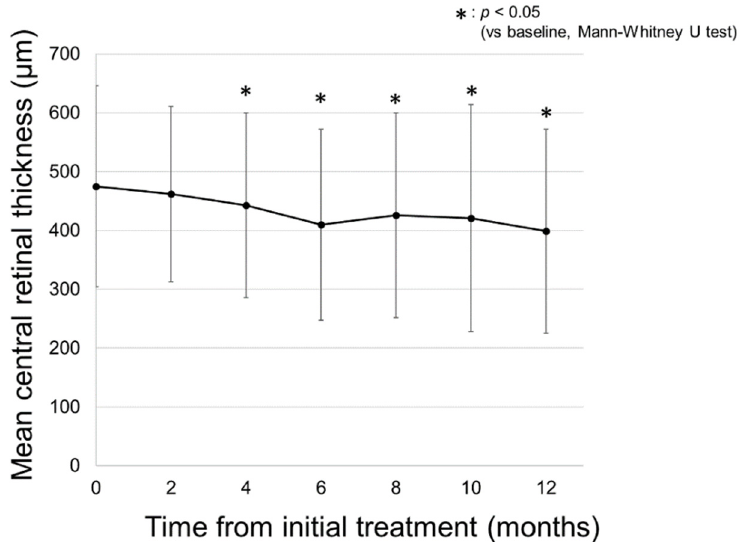
Figure 4. Changes in the mean central retinal thickness (CRT) measured with spectral-domain optical coherence tomography in all patients. The mean CRT in all patients was 475 ± 171 µm at baseline and was 462 ± 149, 443 ± 157, 410 ± 162, 426 ± 174, 421 ± 193, and 399 ± 173 µm at 2, 4, 6, 8, 10, and 12 months, respectively. The mean CRT in all patients significantly decreased at 4 months from baseline, and the significant reduction was maintained throughout the 12 months of the follow-up period ( p = 0.41, 0.04, 0.003, 0.02, 0.03, and 0.003, respectively).